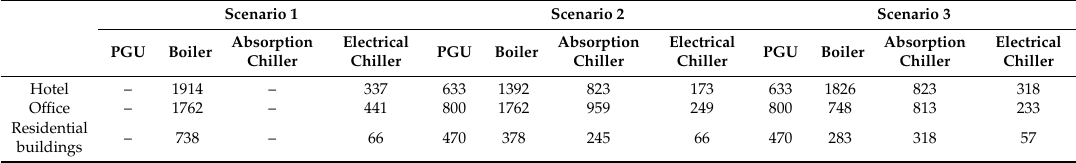
Table 6. Installed capacities of equipment.